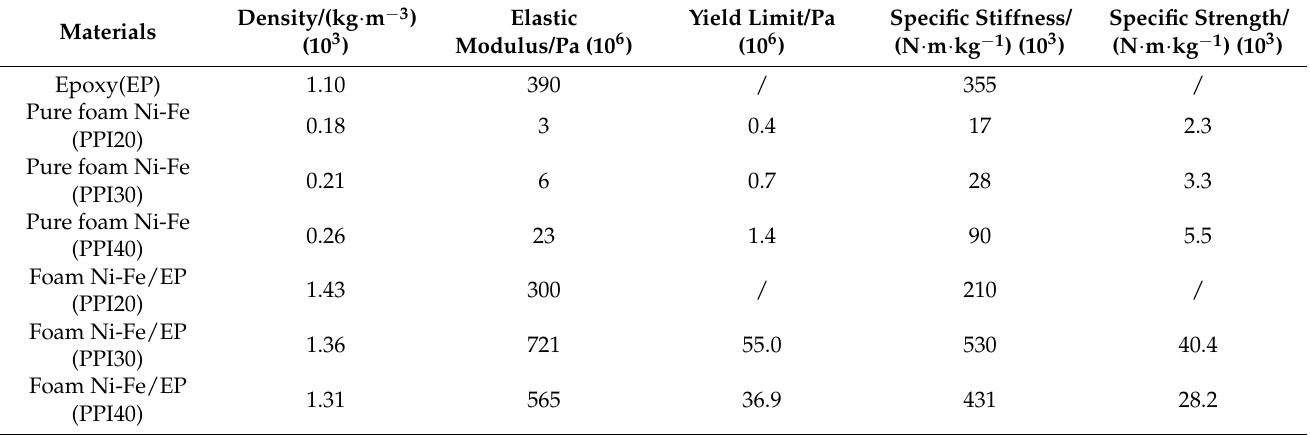
Table 2. Mechanical properties of the seven kinds of